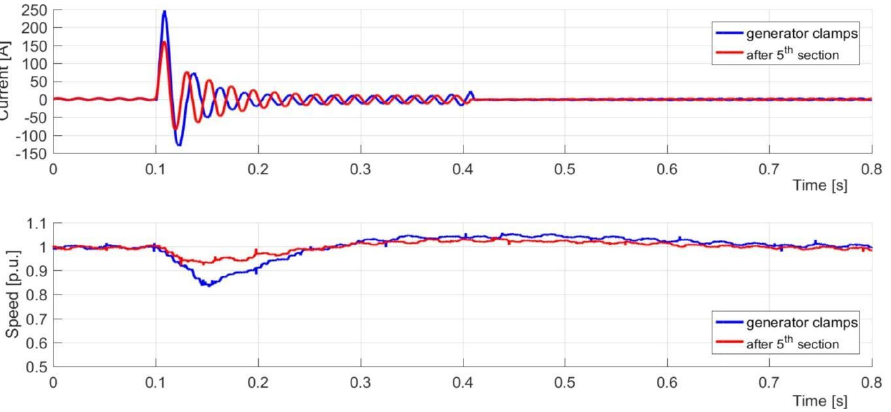
Figure 9 . Comparison of short-circuit currents and the rotor speed of the generator at the generator clamps and after the fifth line section. clamps and after the fifth line section.